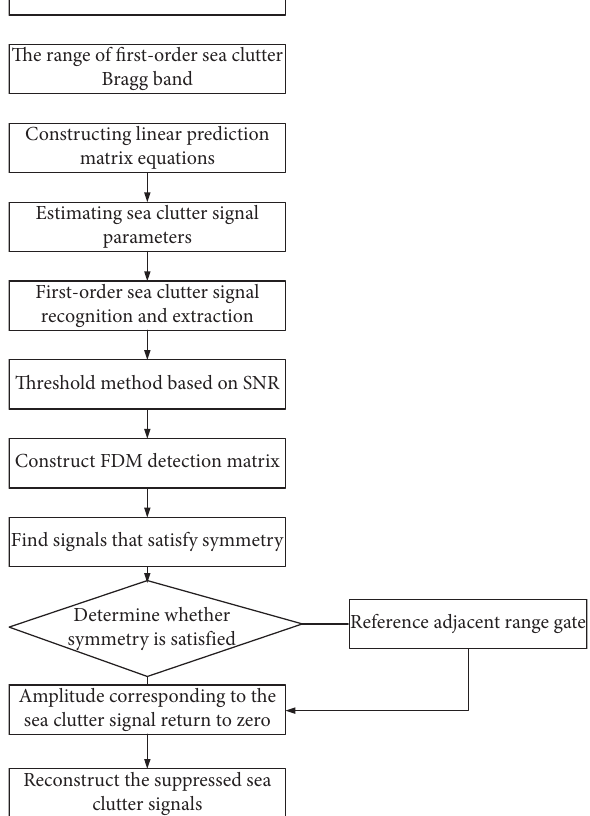
Figure 5: The processing diagram of bistatic sea clutter suppression based on the FBLP